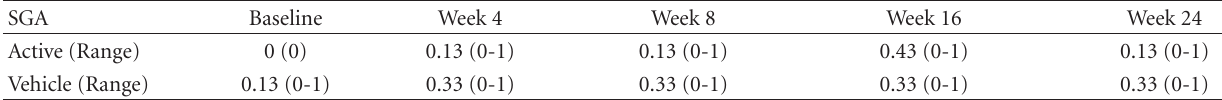
Table 8: Mean Subject’s Global Assessment.